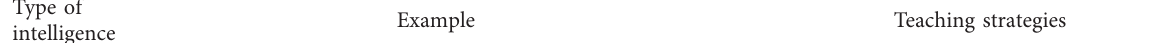
Table 1: Teaching strategies for multiple intelligences